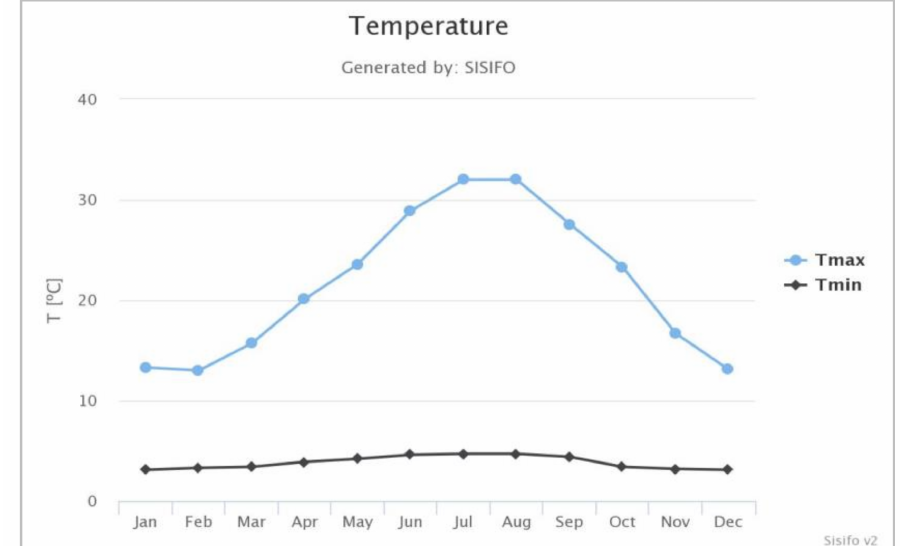
Figure 9. Minimum and maximum monthly ambient temperature.